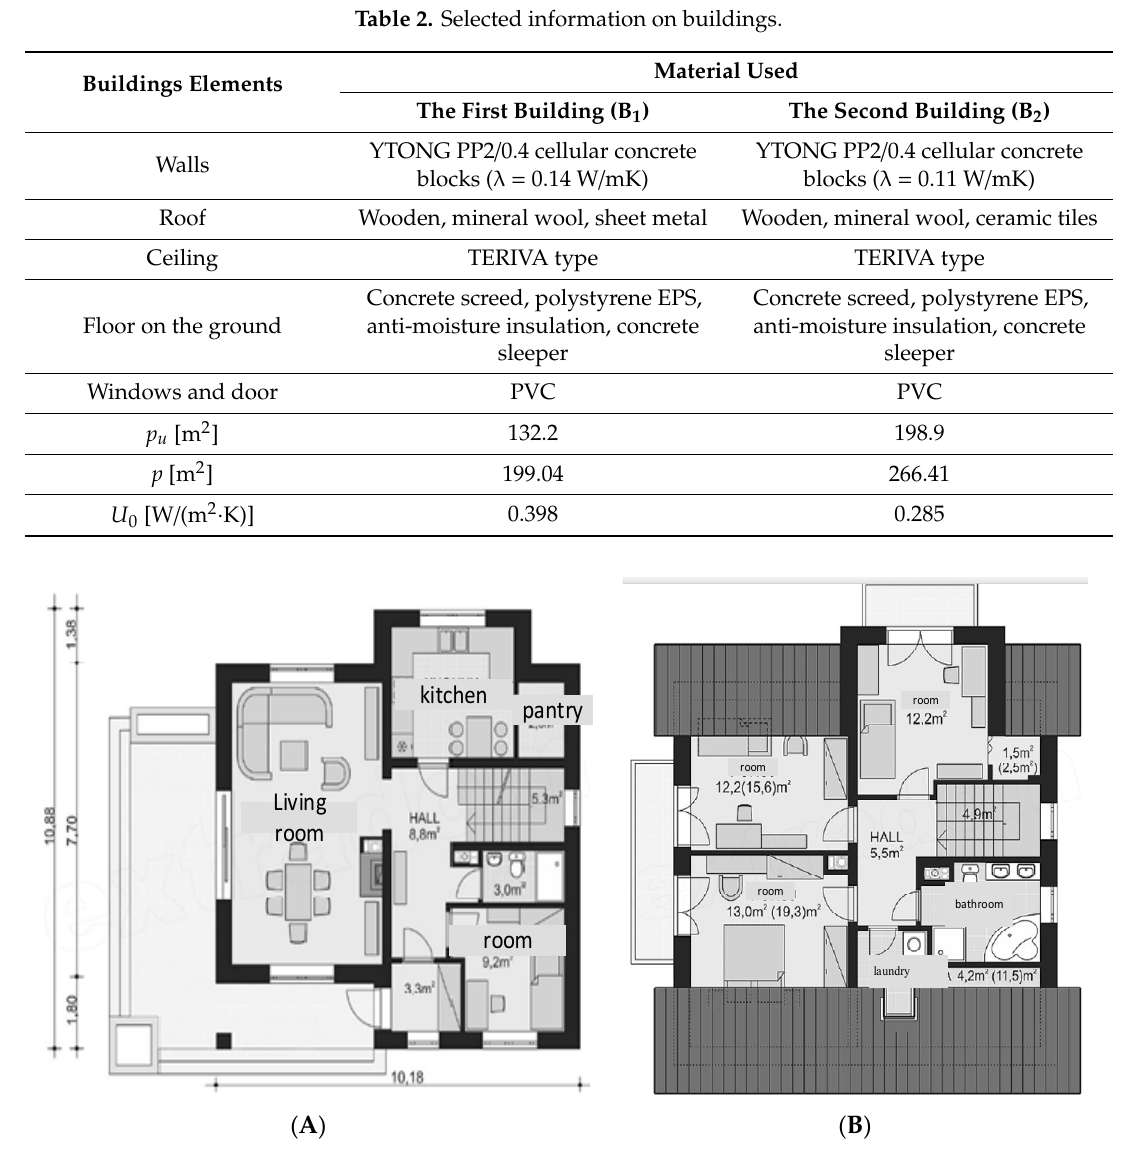
Figure 2. Buildings external partitions (B1 and B2). ( A ) Before thermo-modernization. ( B ) After thermo-modernization. 1. Cellular concrete blocks; 2. Plaster; 3. Thermal insulation.